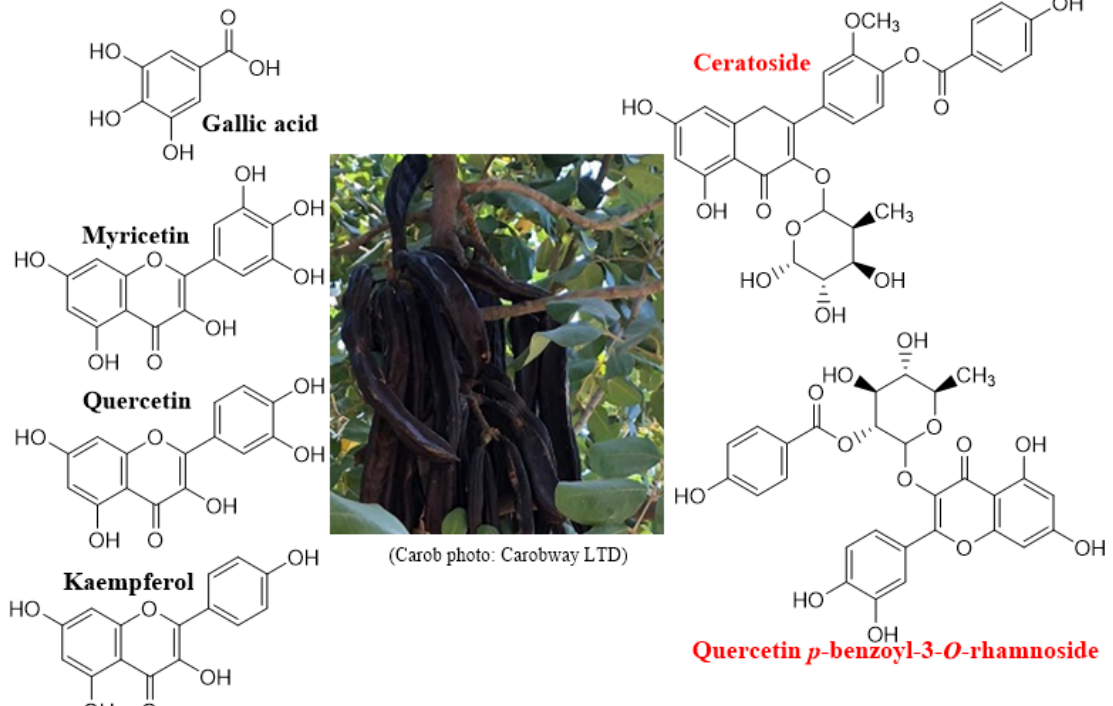
Figure 1. Major and new phenolic compounds found in Carob pods and leaves